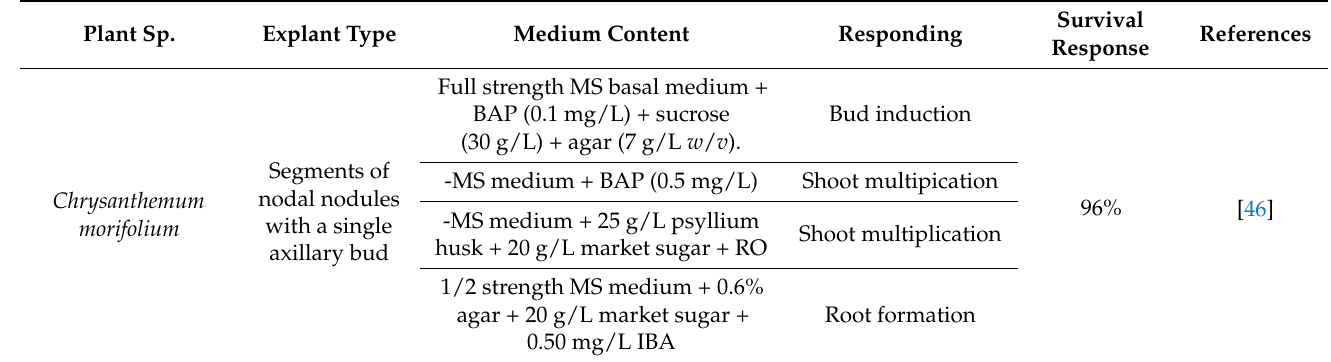
Table 1. Summary of recent studies focused on the optimal cultured medium in vitro for chrysanthe- mum